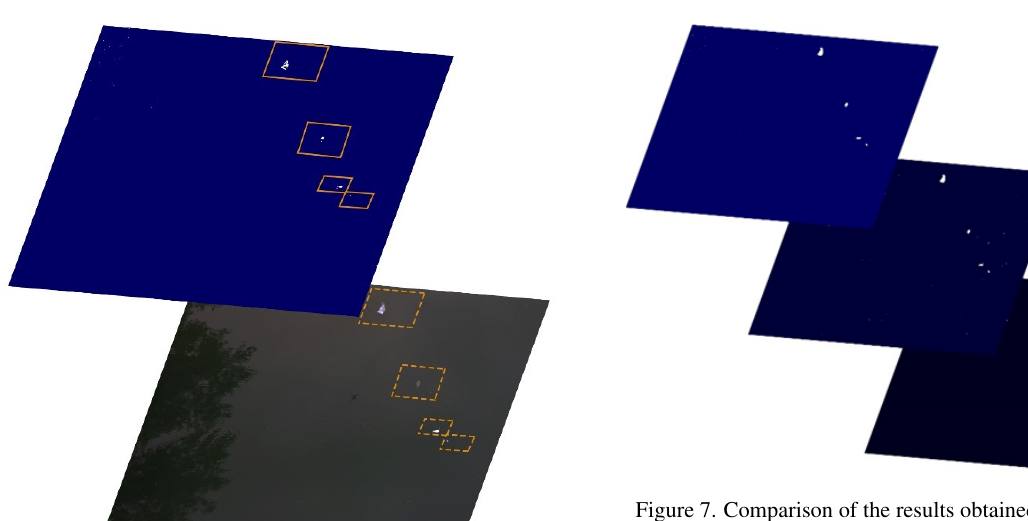
Figure 7. Comparison of the results obtained with classifier B+A, A, and B (from top to bottom).